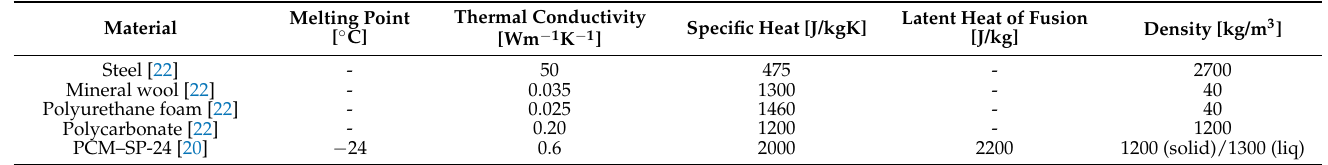
Table 2. Thermophysical properties of materials used in the